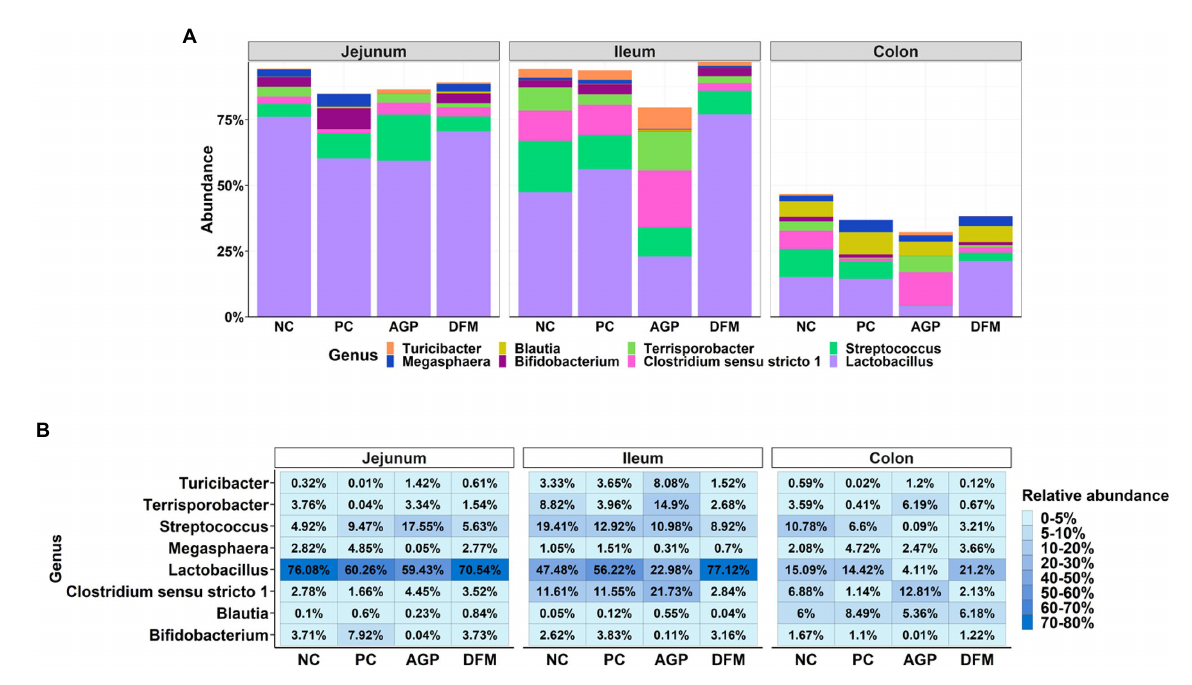
FIGURE 6 Relative abundance of top 8 genus in intestinal microbiota of piglets visualized in bar plot (A) and heatmap (B) . Each mean represents 9–12